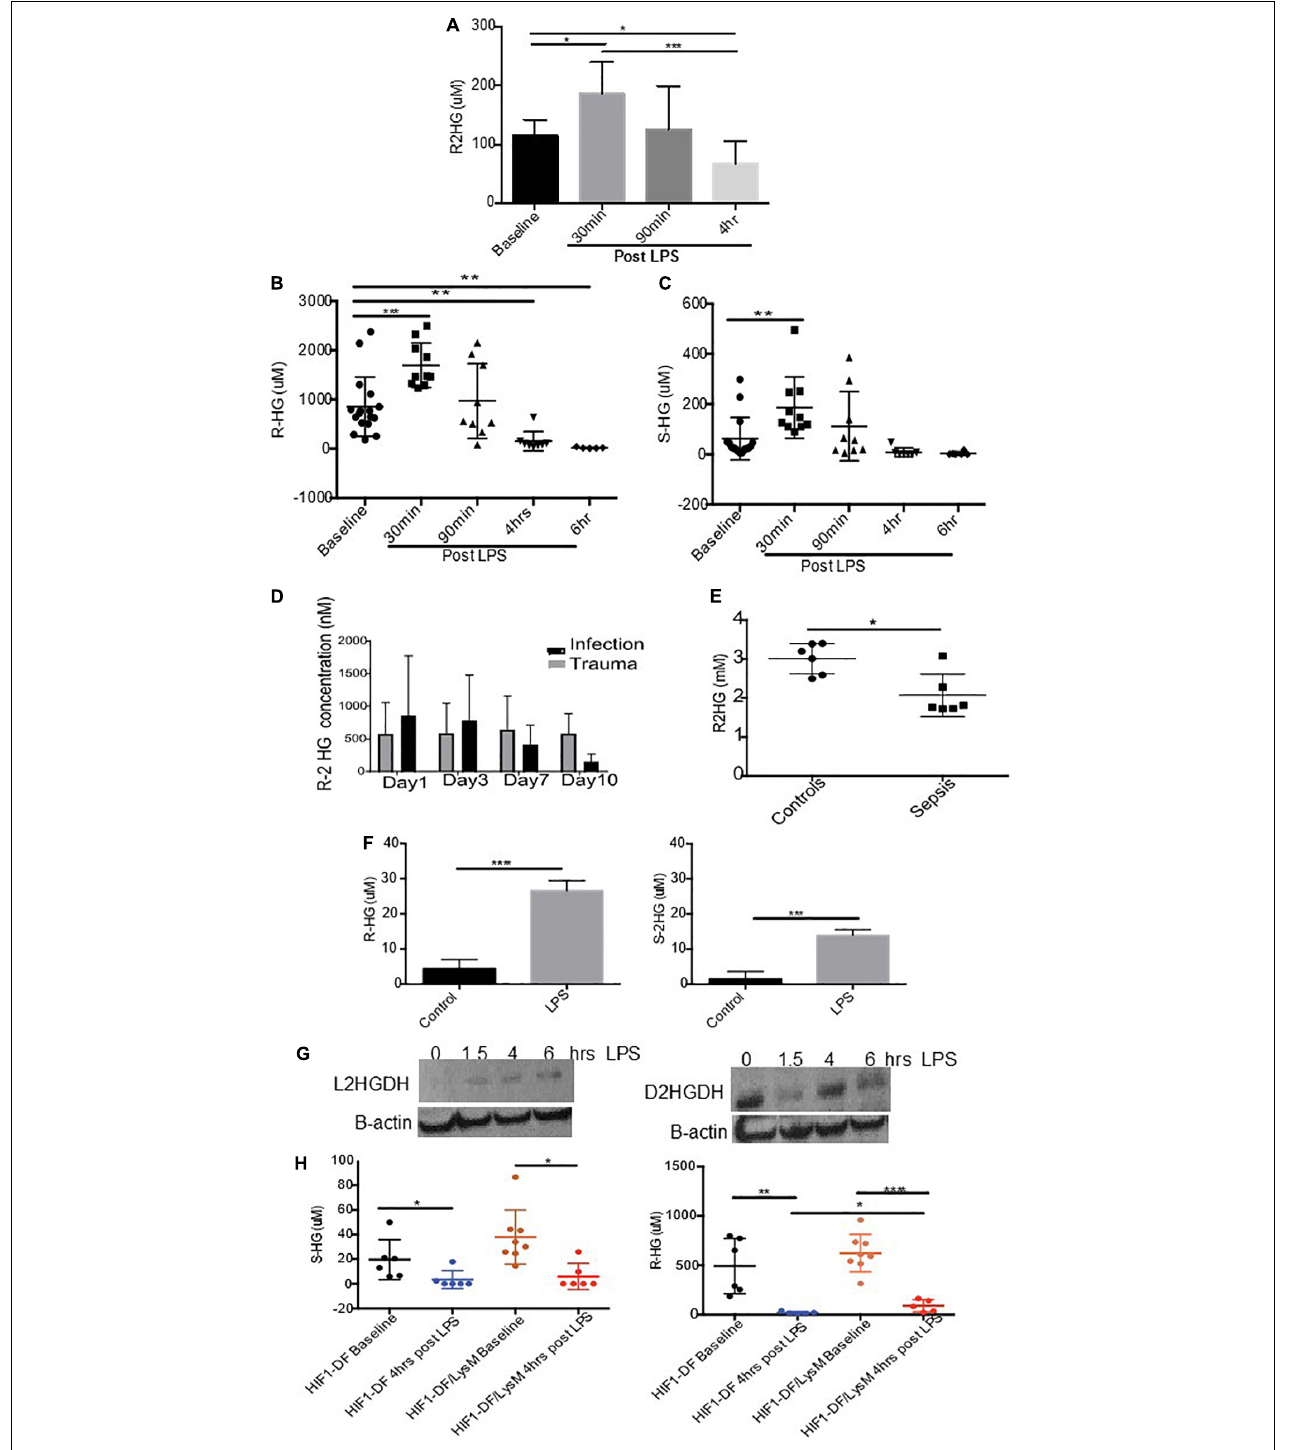
FIGURE 1 | Urinary excretion of 2-HG is suppressed in sepsis. Mice were treated with LPS (15 mg/kg) and urine was obtained over a time course 0–4 h. Urine samples were subsequently measured using a (A) colorimetric assay for R-2HG or mass spectroscopy for (B) R- and (C) S-2HG. N ≥ 7 for all time points. R-2HG levels was quantified in (D) urine or (E) serum isolated from septic patients. (F) R- and S-2HG were quantified by mass spectroscopy in BMDM treated with LPS (1 ug/ml) (G) BMDM were treated with LPS (1 ug/ml). Immunoblotting for L/D-2HGDG protein was performed and quantified by densitometry analysis. N = 3. (H) Urine was taken from wild type (HIF-1DF) and HIF-1DF/LysM mice at baseline. Following LPS (15 mg/kg) administration urine was obtained after 4 h and mass spectroscopy for both R- and S-2HG was performed. N = 6–8 for all time points. * p < 0.05,. ** p < 0.01, *** p < 0.005, and **** p < 0.001.